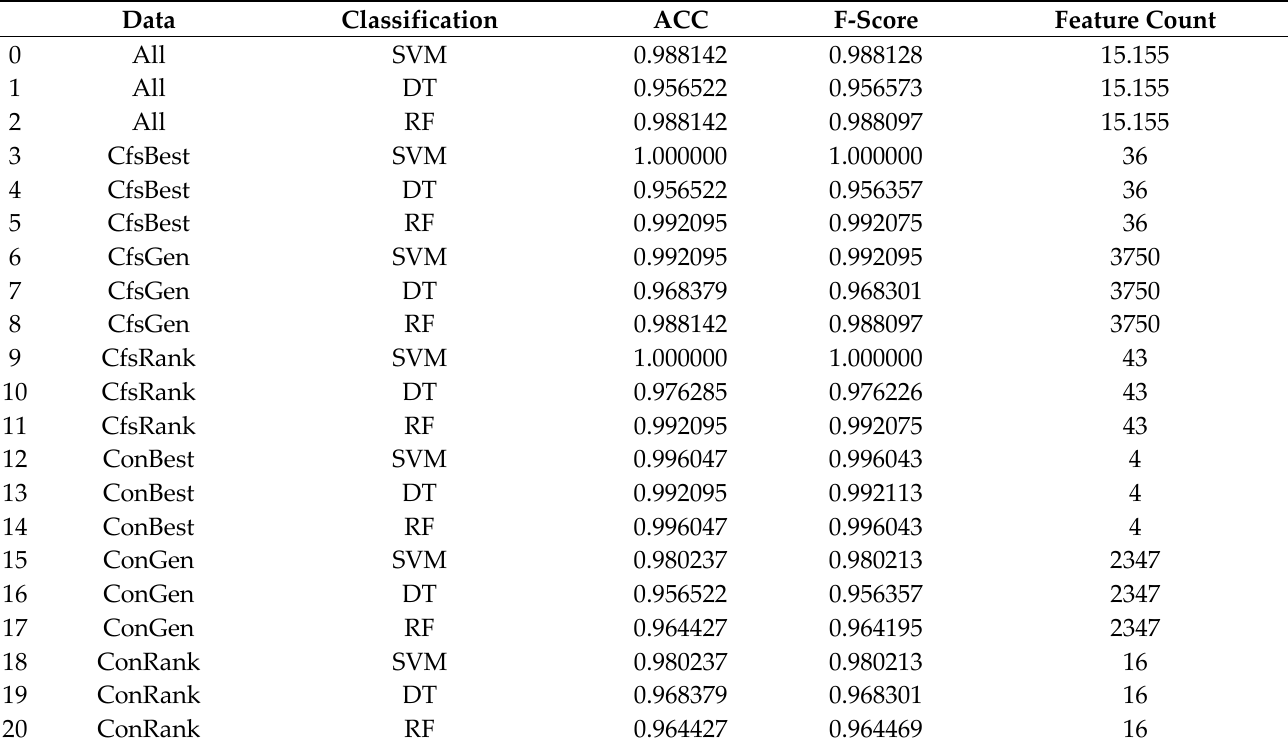
Table 10. Comparison of Classification